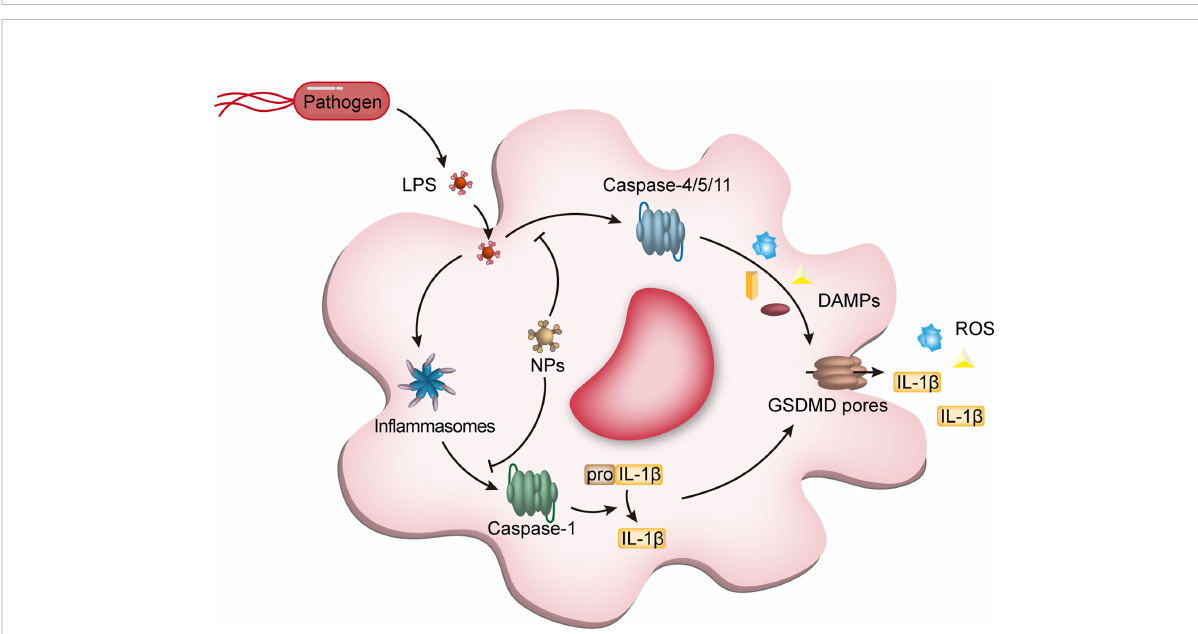
FIGURE 4 NPs interfere with macrophage pyroptosis. Pyroptosis, a class of programmed cell death dependent on pro-in fl ammatory caspases (caspase-1,- 4,-5 from humans and caspase-1 and -11 from mice) and gasdermin D (GSDMD), is an important type of programmed macrophage death. After recognition of LPS derived from pathogens by macrophage intracellular receptors, activation of caspases triggers the cleavage of GSDMD and IL-1 b , which accumulates in the cell membrane to form pores causing cell membrane collapse, accompanied by the release of in fl ammatory cytokines, including IL-1 b , ultimately leading to cell death. The NPs entering the cells can block the activation of caspase-1 and caspase4/5/11, reducing the release of DAMPs and avoiding unnecessary tissue and cell damage. NPs, nanoparticles; LPS, lipopolysaccharides; IL-1 b , interleukin-1 b ; DAMPs, damage-associated molecular pattern molecules; GSDMD, gasdermin